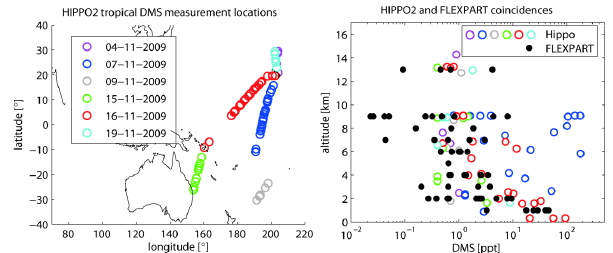
Fig. 5. Atmospheric vertical DMS distribution computed along the TransBrom cruise track given as (a) amount relative to DMS emis- sion from the sea surface (%) and (b) total amount [kg]. Atmo- spheric DMS distribution is based on FLEXPART simulations with a 1 / 2-day atmospheric lifetime. DMS emission at the ocean surface over 500m 2 and one hour is given as the black line corresponding to the right y